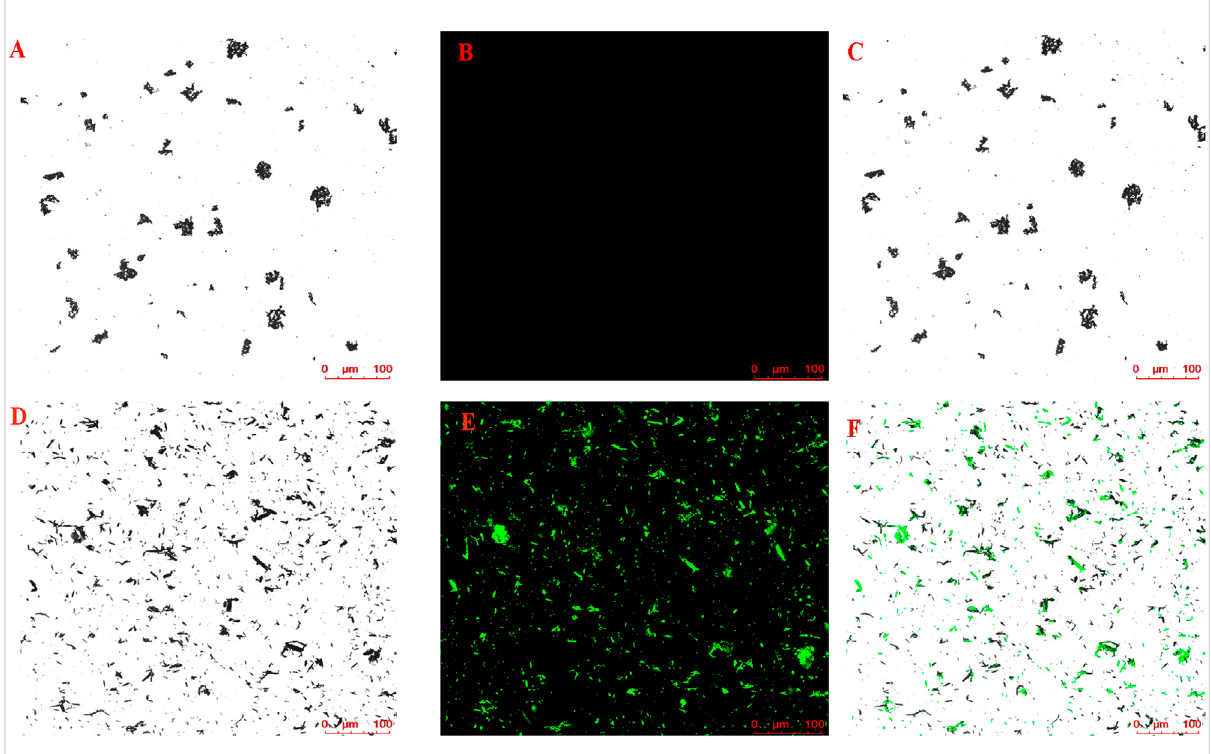
FIGURE 2 Confocal microscopic images of (A – C) CMs@HT22-MBs and (D – F) MBs. CMs@HT22-MBs and MBs were incubated with fl uorescein isothiocyanate-conjugated 1,2-distearoyl- sn -glycero-3-phosphoethanolamine polyethylene glycol (DSPE-PEG-FITC, molecular weight: 2,000) with a concentration of 1 mg/ml at 37 ° C for 30 min respectively, and then PBS were washed three times to remove excess dyes. The fl uorescently labeled substances were then examined using laser scanning confocal microscopy laser scanning confocal microscopy. (A,D) Bright fi eld. (B,E) Excitation at 488 nm to visualize DSPE-PEG-FITC-labeled CMs. (C) Merged images of A and B and (F) D and